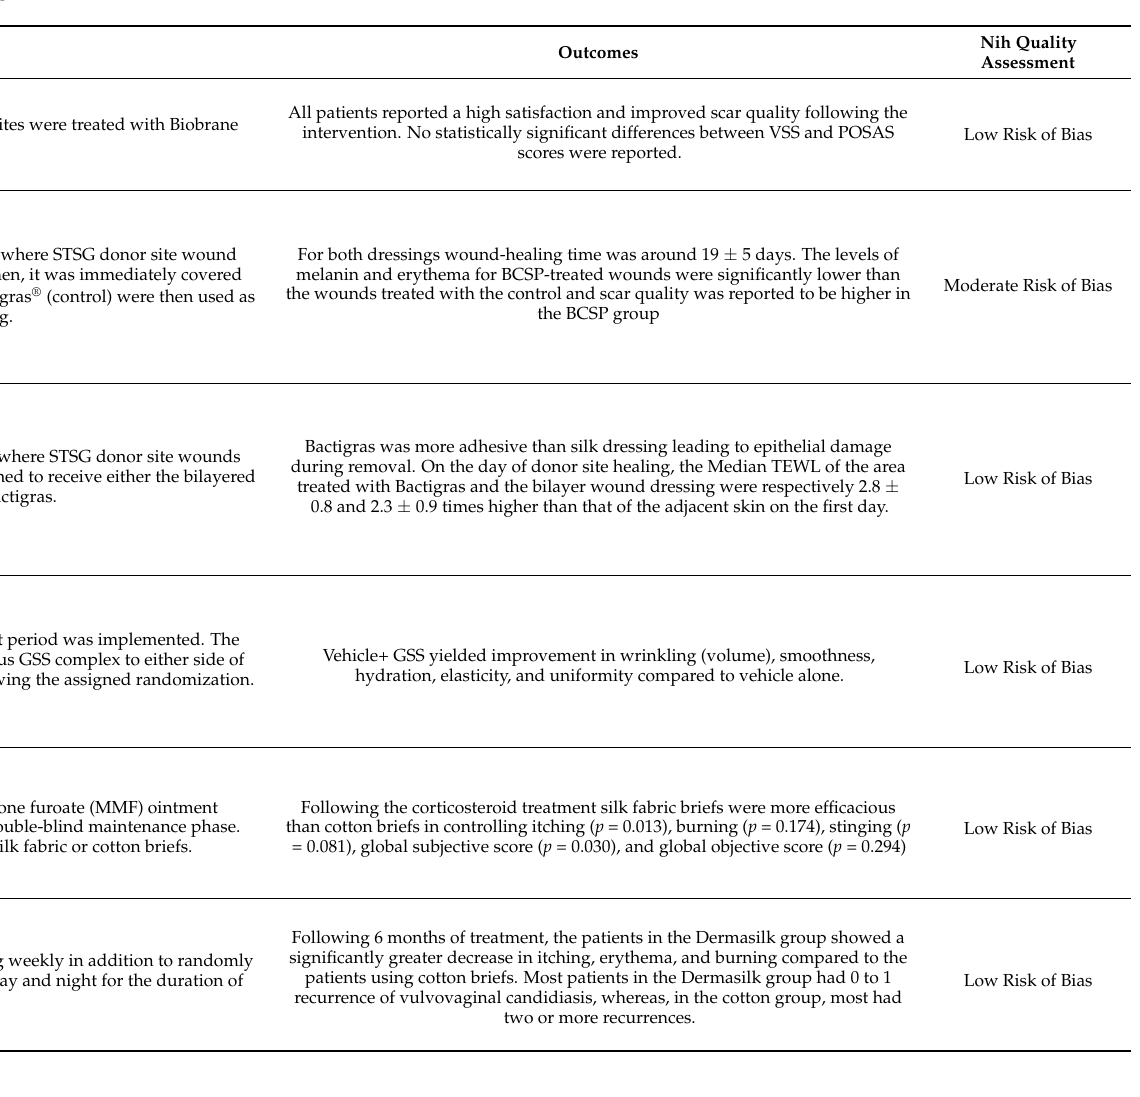
Table 2. Study protocols and reported